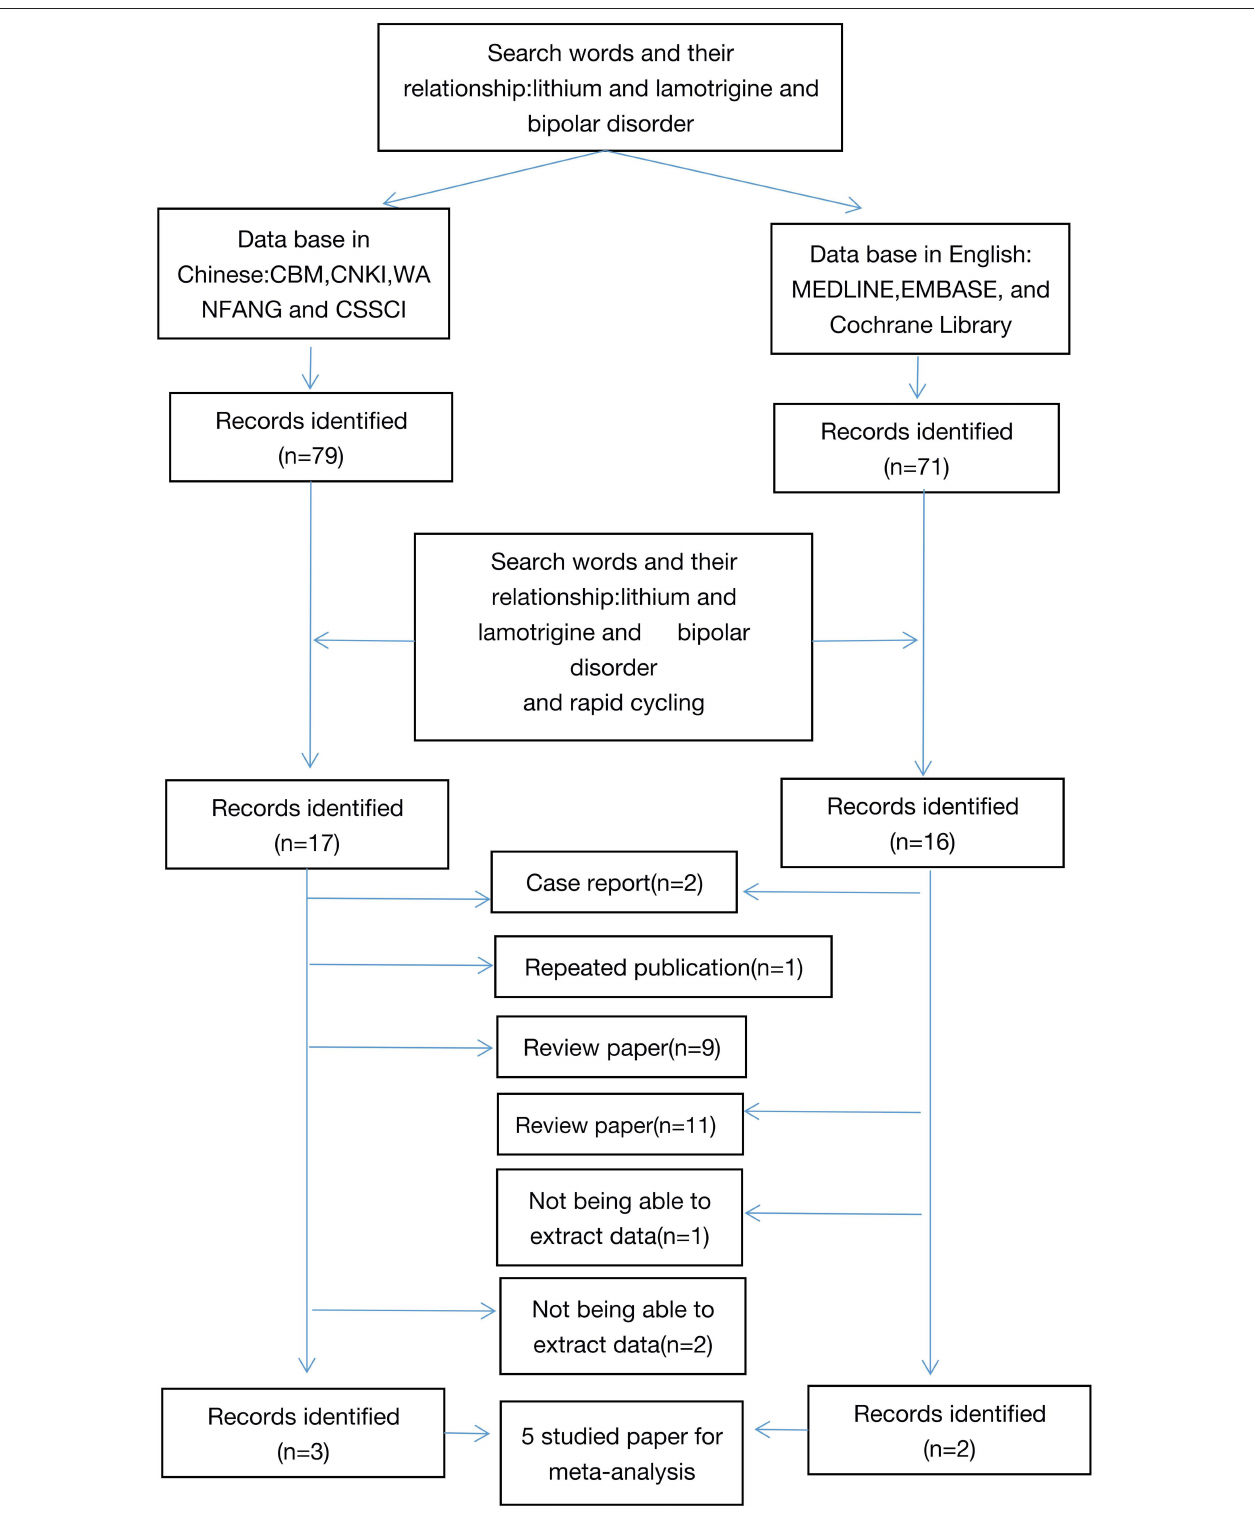
FIGURE 1 | Flowchart of selection of studies for inclusion in meta-analysis.